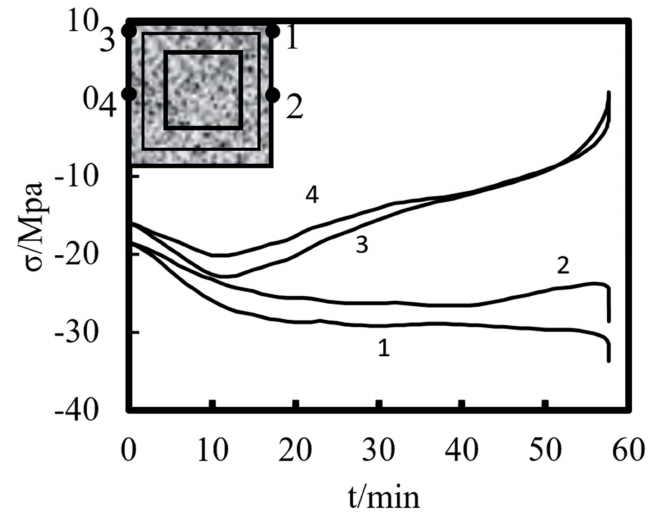
Figure 13. Stress–time curve of the external concrete at various points in the half-height